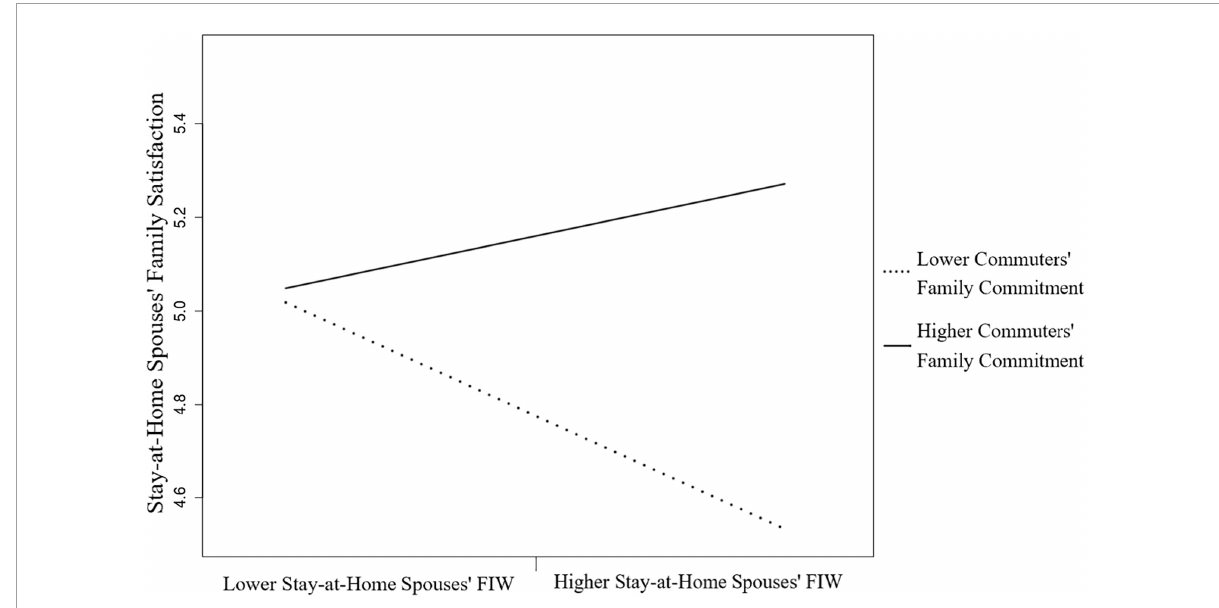
FIGURE2 The moderating effect of commuter’s family commitment of the FIW and family satisfaction relation for stay-at-home spouses.